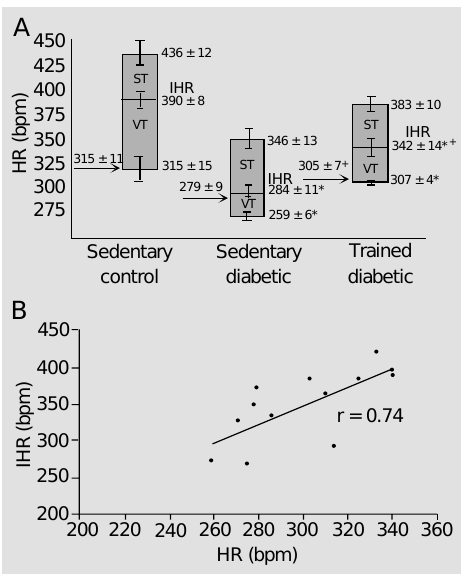
0.74Figure 1 - A , Graphs showing in- trinsic heart rate (IHR), sympa- thetic (ST) and vagal tonus (VT) in sedentary control, sedentary diabetic and trained diabetic rats. Arrows indicate basal heart rate (HR). Data are reported as means ± SEM. *P<0.05 com- pared to sedentary control rats; + P<0.05 compared to sedentary diabetic rats (ANOVA). B , Posi- tive relationship between rest- ing HR and IHR expressed by linear regression line (r = 0.74) in the diabetic groups